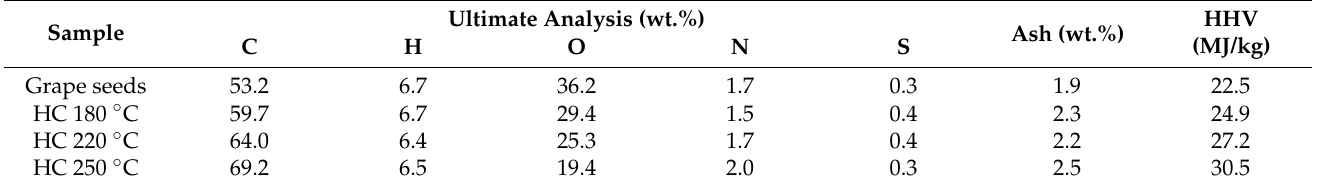
Table 1. Grape seeds and hydrochar (HC) properties, from the literature [32] (C: carbon, H: hydrogen, O: oxygen, N: nitrogen, S: sulfur, HHV: higher heating